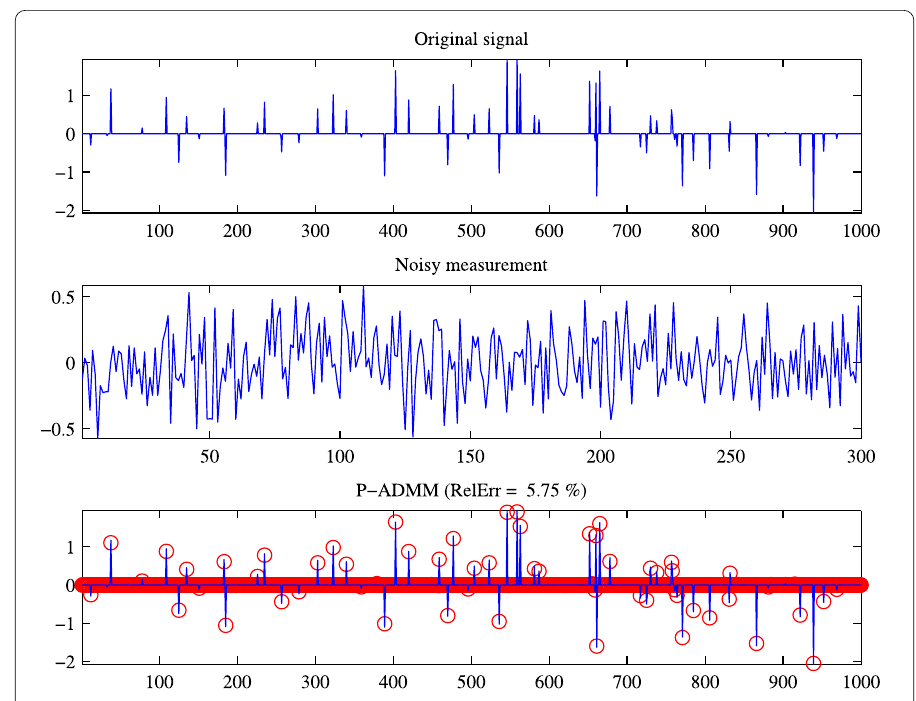
Figure 3 The original signal, noisy measurement and recovered